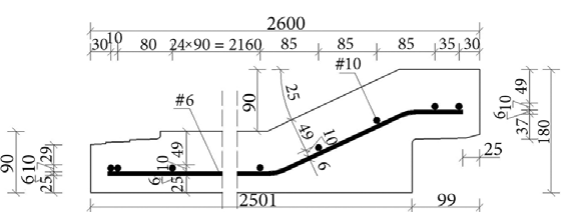
Fig. 2. The adopted cover of main reinforcement and the reinforcement spacing for the analysed the pipes